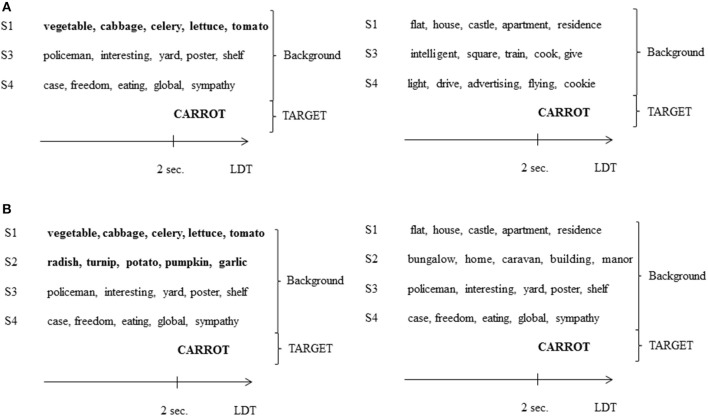
(A) Example of a background in the 1SC/2SI condition of Experiment 3, presented with a semantically related target word (left; related condition) or not (right; unrelated condition). S4, speaker 4 (see the legend of Figures 1, 2 for other abbreviations). (B) Example of a background in the 2SC/2SI condition of Experiment 3, presented with a semantically related target word (left; related condition) or not (right; unrelated condition).